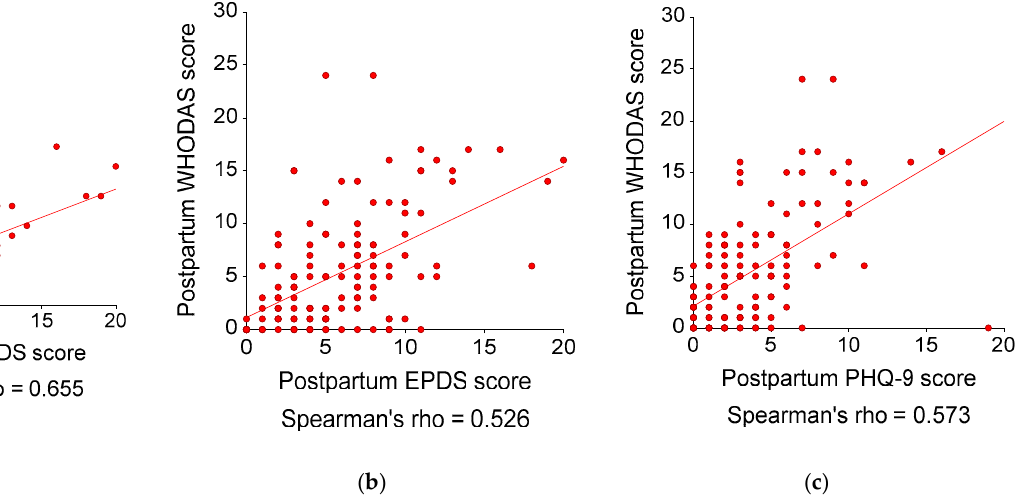
Figure 3. Correlations among EPDS, PHQ-9, and WHODAS scores and regression lines in 136 postpartum participants (postpartum data only): ( a ) Correlation between postpartum EPDS and PHQ-9 scores: Spearman’s rho (95% CI; p -value) = 0.66 (0.55, 0.74; p < 0.001); ( b ) Correlation between postpartum EPDS and WHODAS scores: Spearman’s rho (95% CI; p -value) = 0.53 (0.39, 0.64, p < 0.001); and ( c ) Correlation between postpartum PHQ-9 and WHODAS scores: Spearman’s rho (95% CI; p -value) = 0.57 (0.45, 0.68; p < 0.001). EPDS, Edinburgh Postnatal Depression Scale; PHQ9, 9-item Patient Health Questionnaire; WHODAS, 12-item World Health Organization Disability Assessment